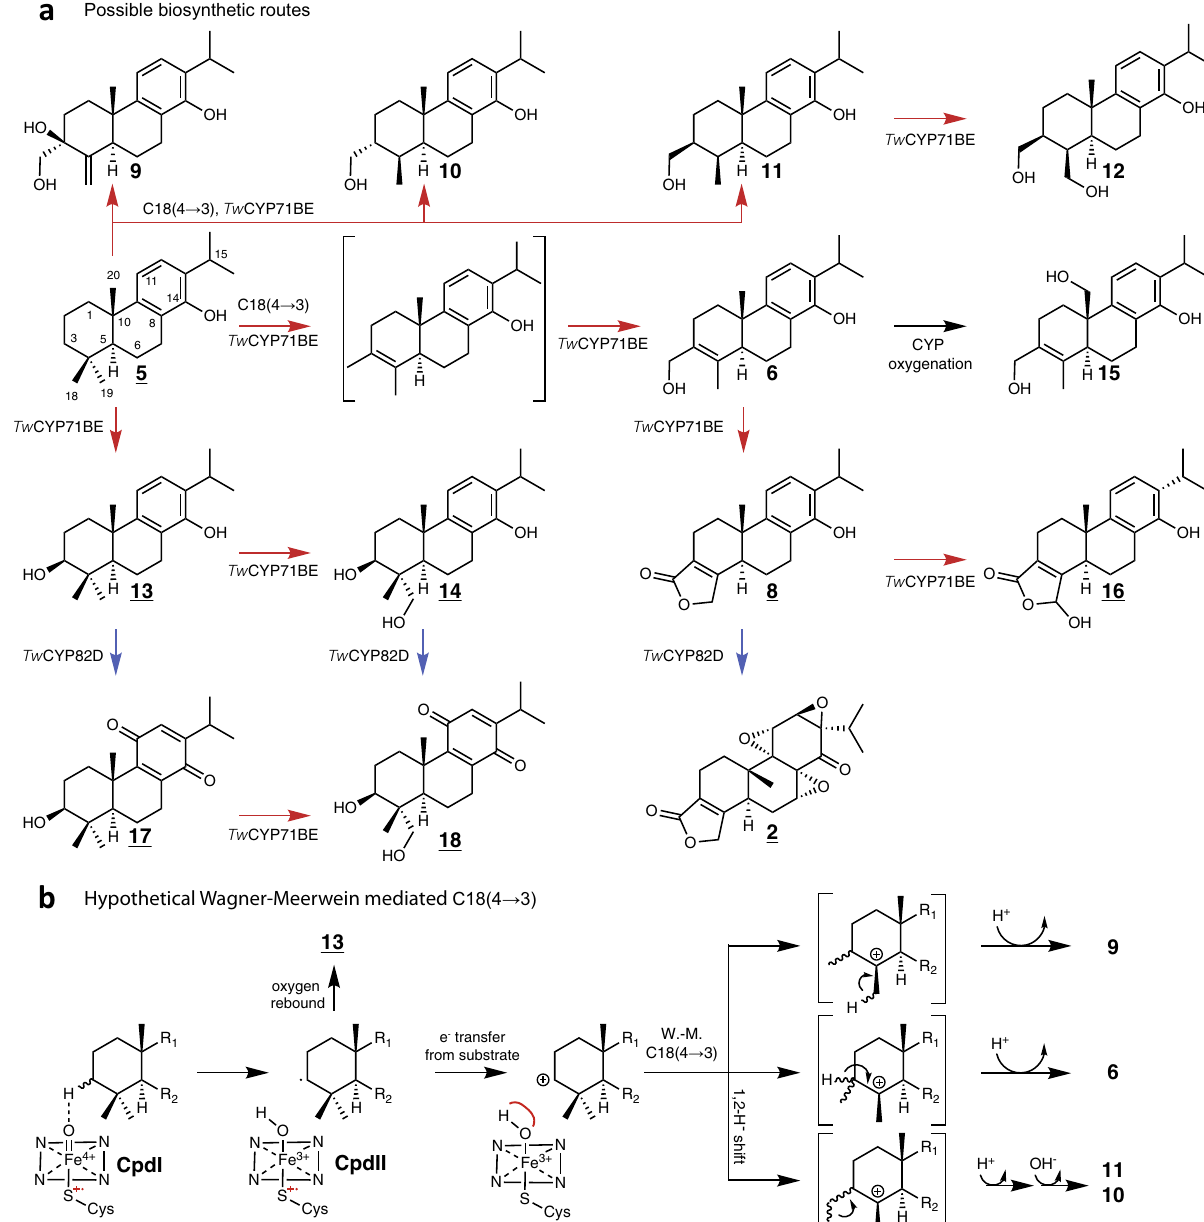
Fig. 4 | Proposed biosynthetic pathway of triptonide (2) from 14-hydroxy- dehydroabietadiene (5) in S. cerevisiae . a The biosynthetic pathway from 5 to 2 illustrating the formation of oxygenated miltiradiene derived intermediates cata- lyzed by the action of Tw CYP82 ’ s (blue arrows) and Tw CYP71BE ’ s (red arrows) on the A- and C-ring of the abietane diterpene backbone, respectively. Underlined compounds or diastereomers hereof have previously been identi fi ed in plant extracts from Tripterygium species (Supplementary Table 1). b a hypothetical Wagner-Meerwein rearrangement reaction (W.-M.) to account for the methyl shift of C-18 to C-3 in the abietane carbon backbone. Cpd I and Cpd II represents states